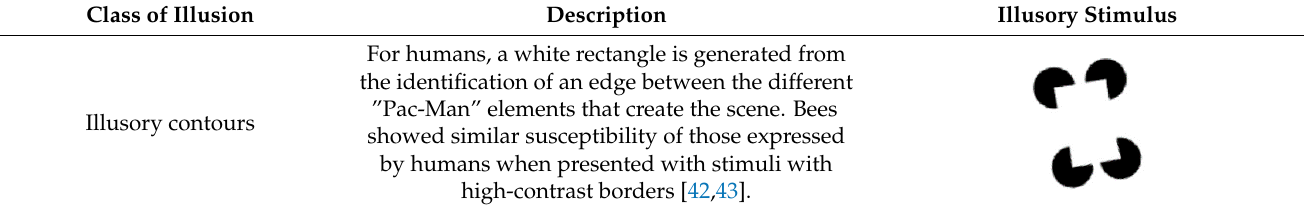
Table 1. Diagram and descriptions of illusory phenomena similarly experienced by bees and human.